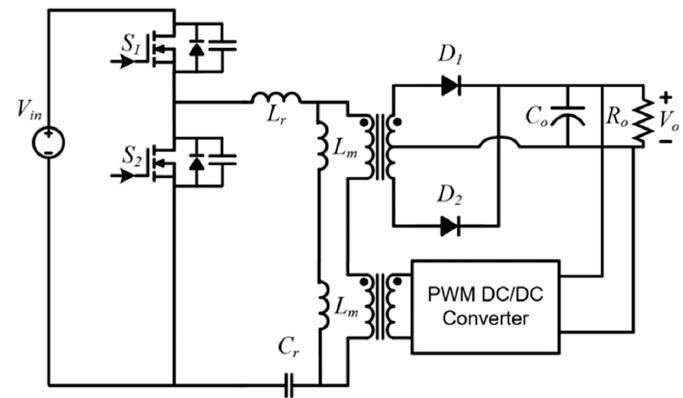
Figure 9. DC transformer with additional output voltage regulating converter.